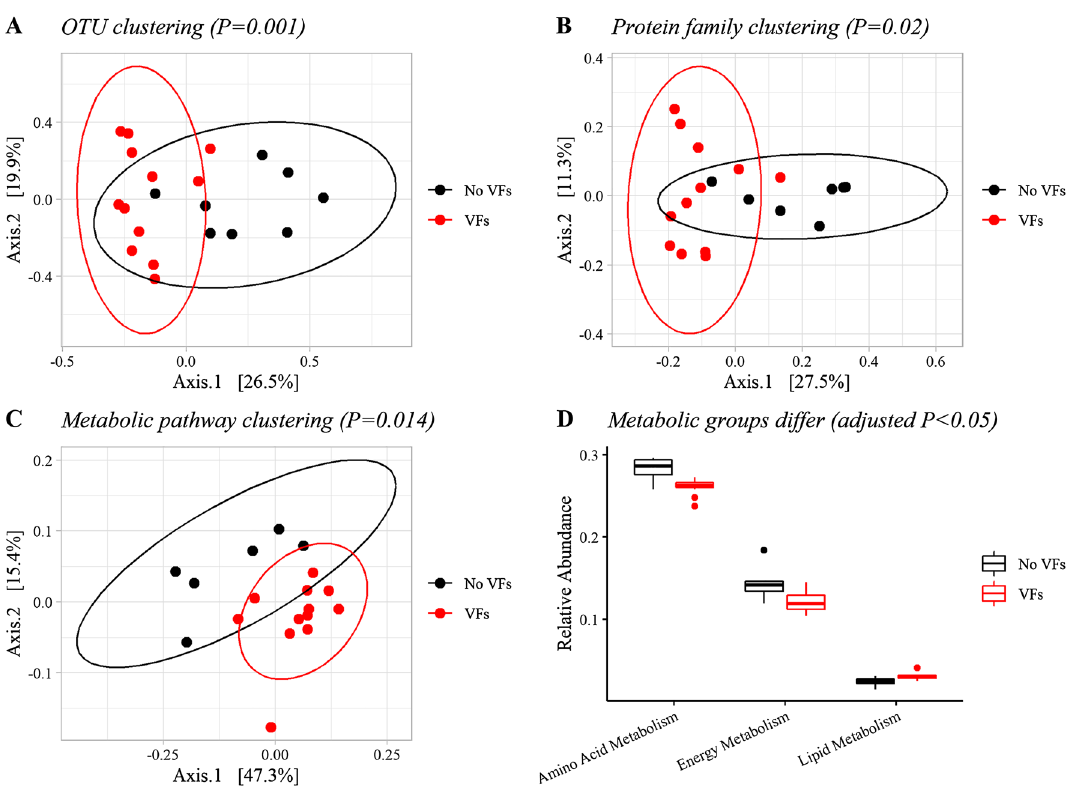
Figure 4. The penguin microbiome varied with C. perfringens virulence factors (VFs). Principal Coordinates Analysis showed distinct clustering based on OTUs from 16S rRNA gene sequencing data ( A ), protein families from shotgun sequencing data ( B ), and KEGG metabolic pathways from shotgun sequencing data ( C ) when separated by Jaccard distance and sorted by the presence of C. perfringens virulence factors from the VFDB. Relative abundance of three metabolic groups significantly varied in the presence of C. perfringens ( D ). Figure created in R using tidyverse (v. 1.3.1) 96 , phyloseq (v. 1.40.0) 67 , and cowplot (v. 1.1.1) 97